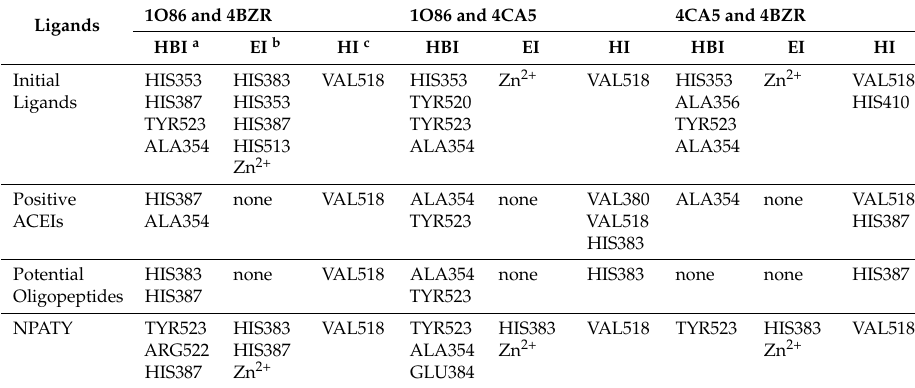
Table 4. The pairwise comparison of interaction residues for three crystal structures.